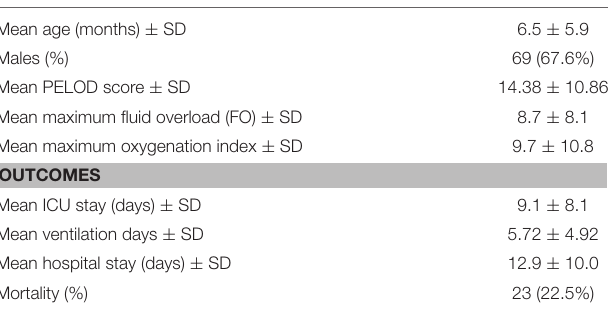
TABLE 1 | Descriptive statistics of study parameters and outcomes.